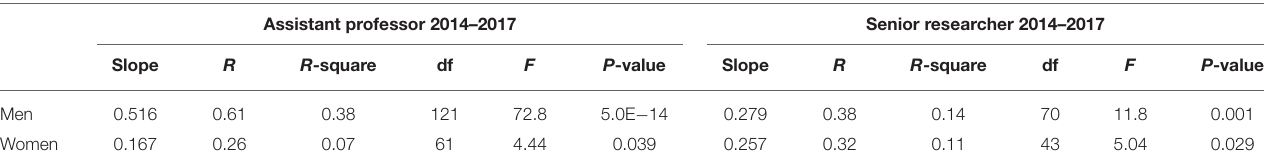
TABLE 3B | Linear regression results for associations between composite bibliometric scores and external reviewer scores in independent individuals (re-applying applicants are included only for their first application), stratified by gender.